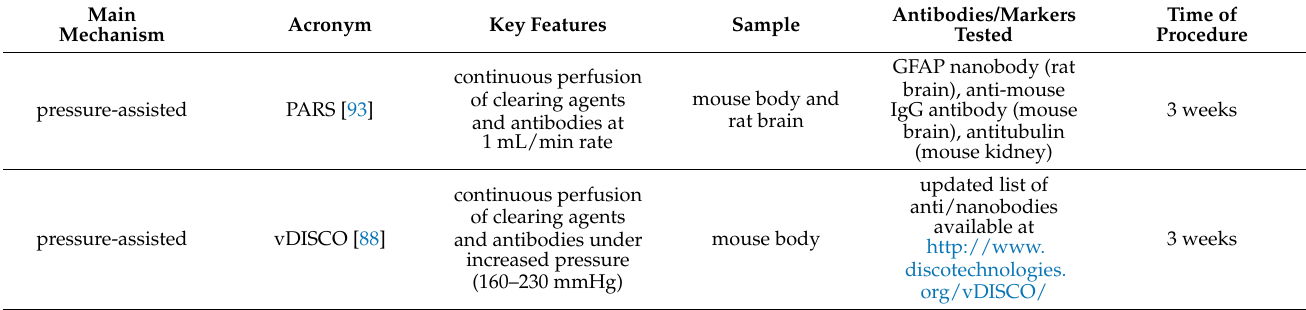
Table 4. TOC methods that increase depth and homogeneity of molecular probe